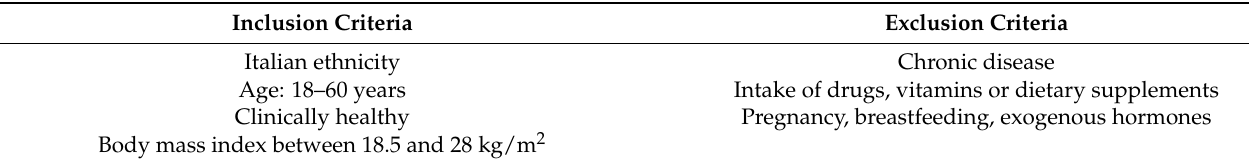
Table 1. Inclusion and exclusion criteria of the